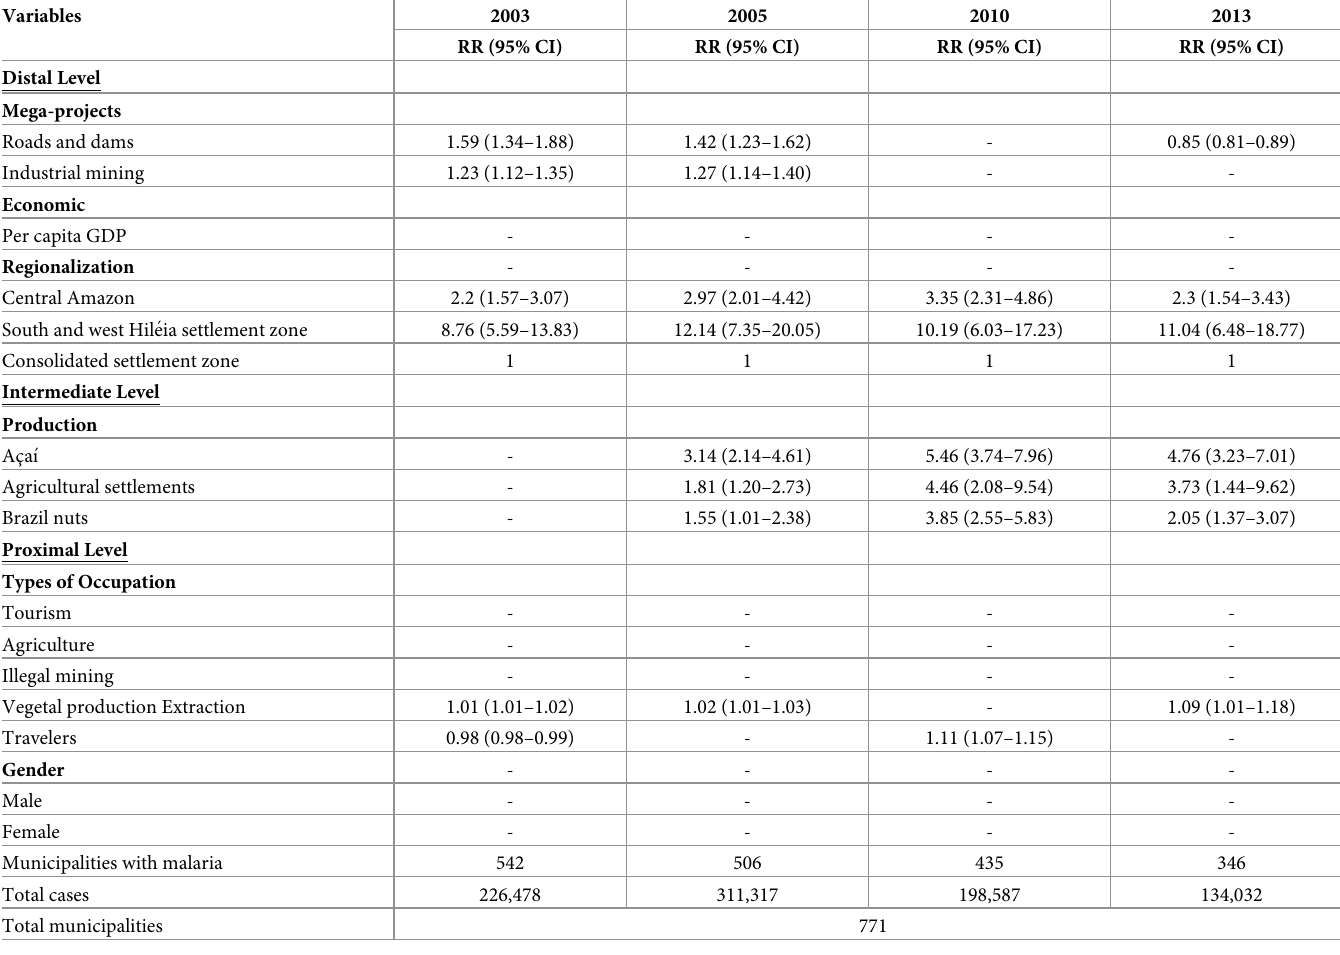
Table 4. Risk factors of malaria associated with occupation for P . vivax by